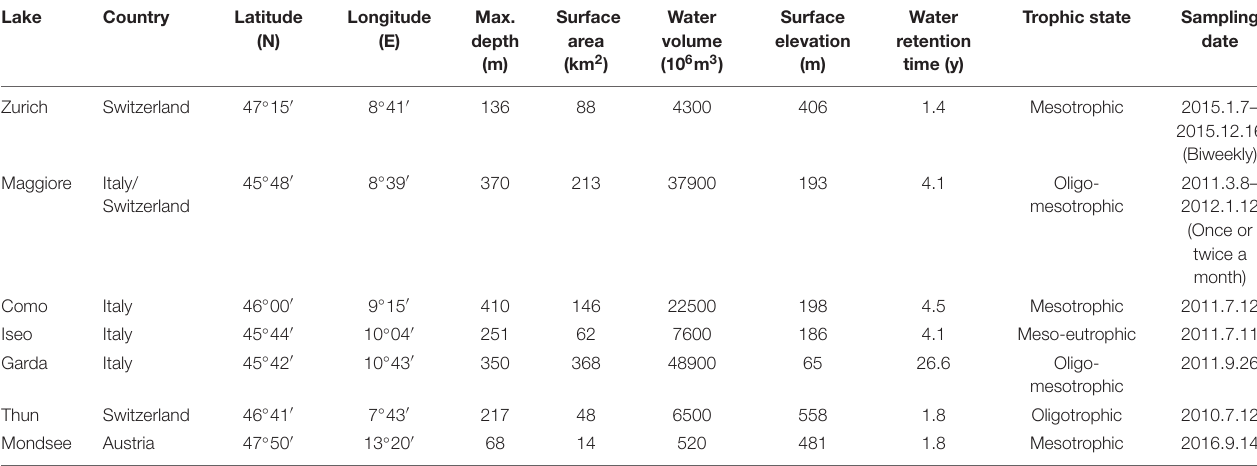
TABLE 1 | Limnological characteristics of the study sites. Lake Country Latitude